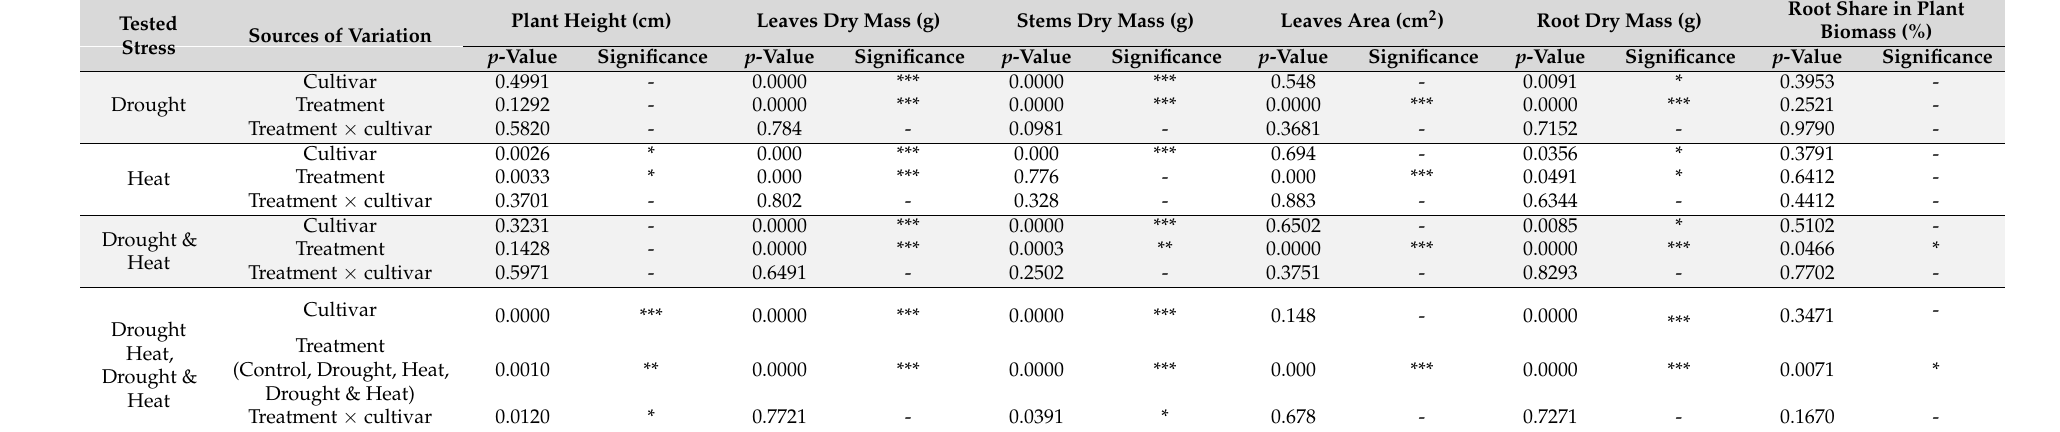
Table 1. Sources of variation, ANOVA results and levels of significance ( p -values) for treatments affecting tested